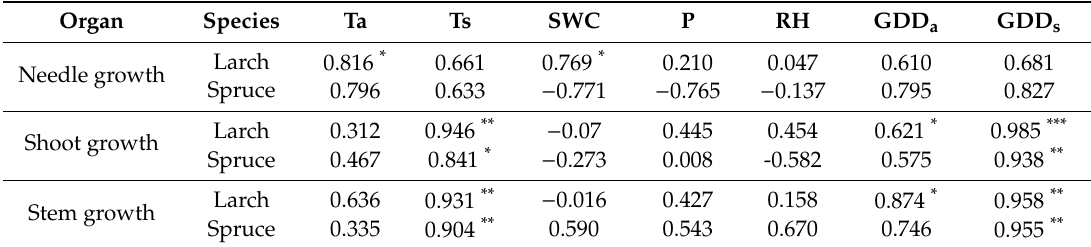
Table 4. Pearson correlation coe ffi cients between tree growth (primary and secondary) and environmental factors of larch and